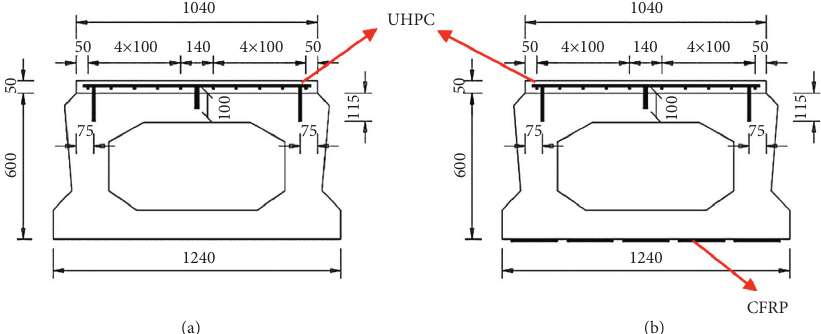
Figure 3: Midspan cross section of Specimen S2 and S3. (a) Specimen S2. (b) Specimen S3.